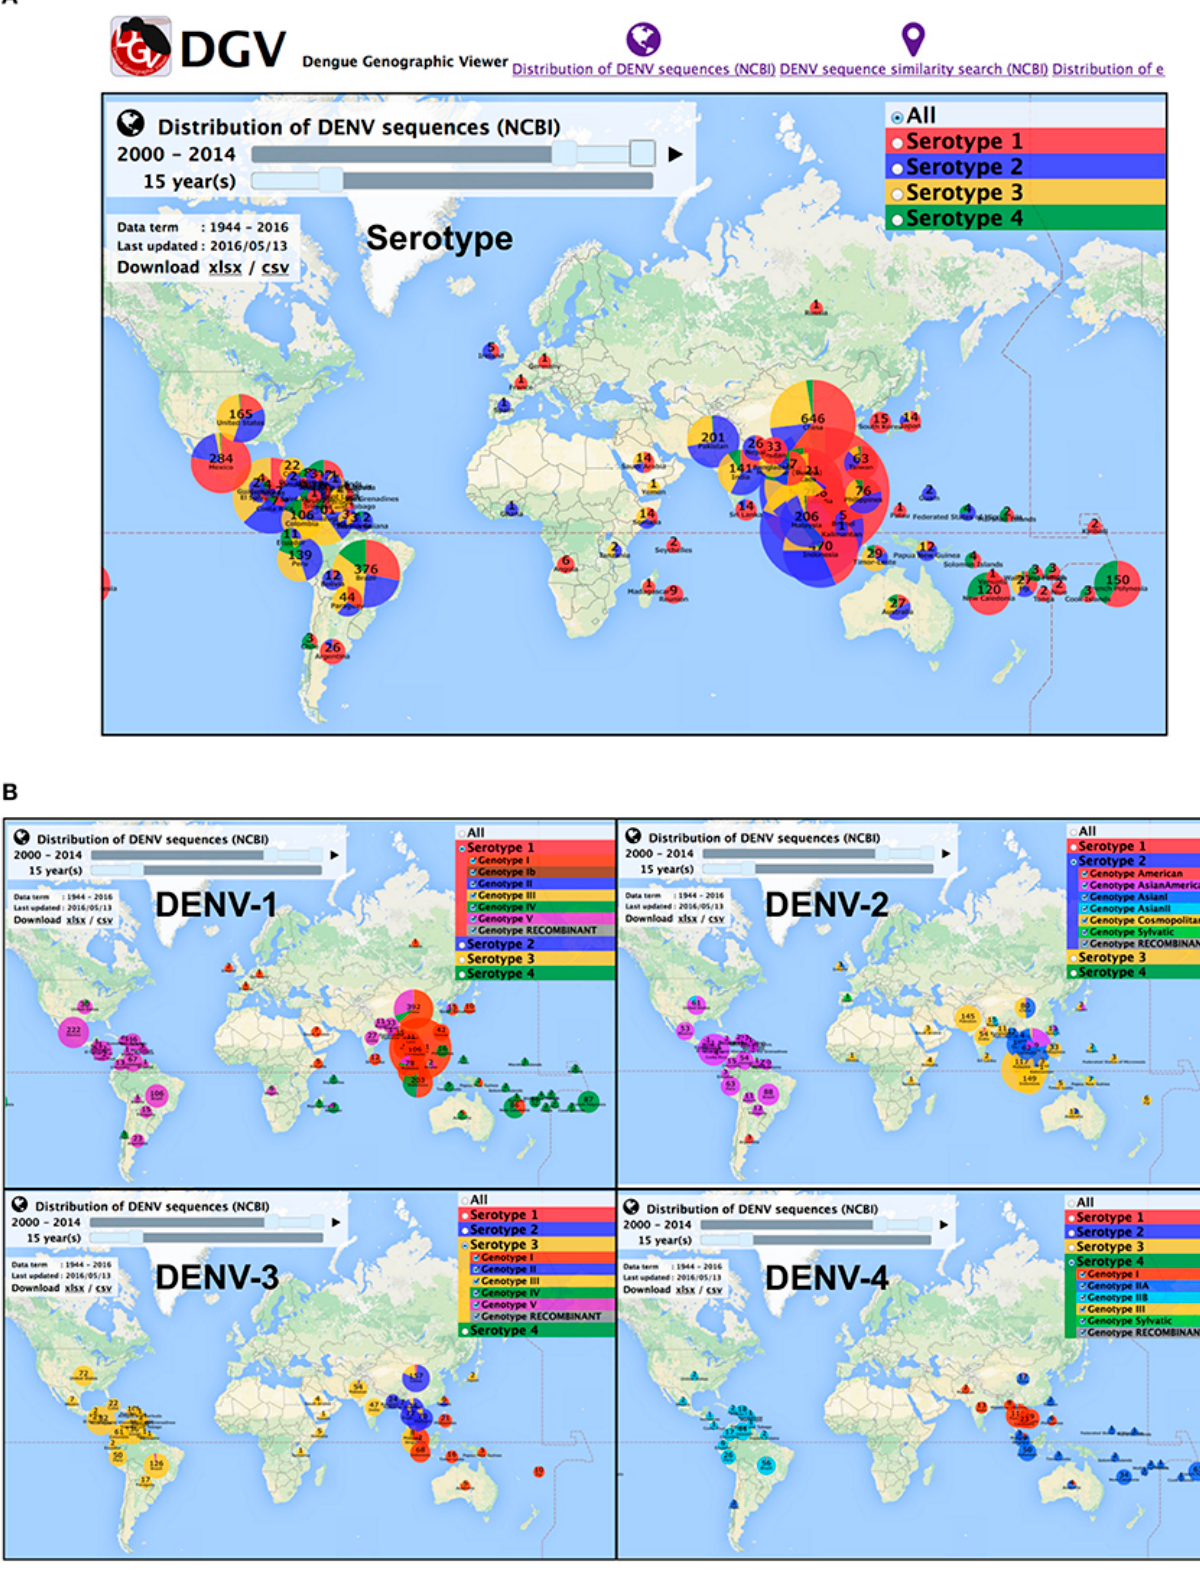
Figure 1. Overview of DENV serotypes and genotype global distribution in 2000–2014. ( A ) DENV serotypes distribution ( B ) DEN genotypes distribution for each serotype. Source: Yamashita et al., 2016 [12].